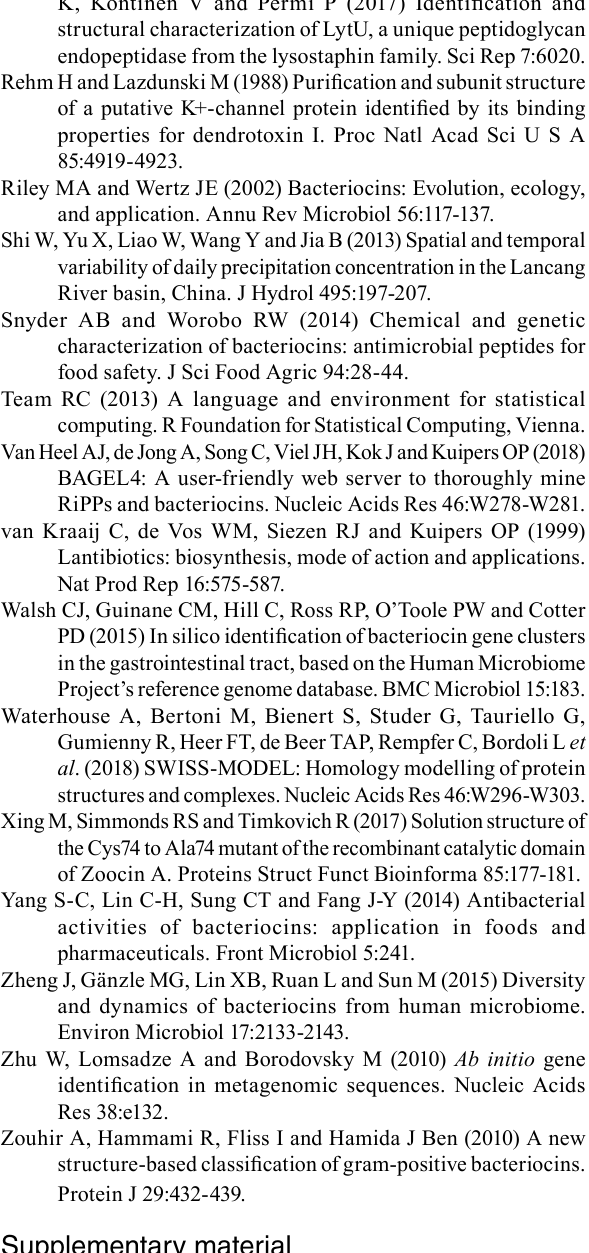
Table S2 – Assembly statistical data of the photic zone. Figure S1 – RMSD plot computed along 10 ns of MD simulations for zoocin